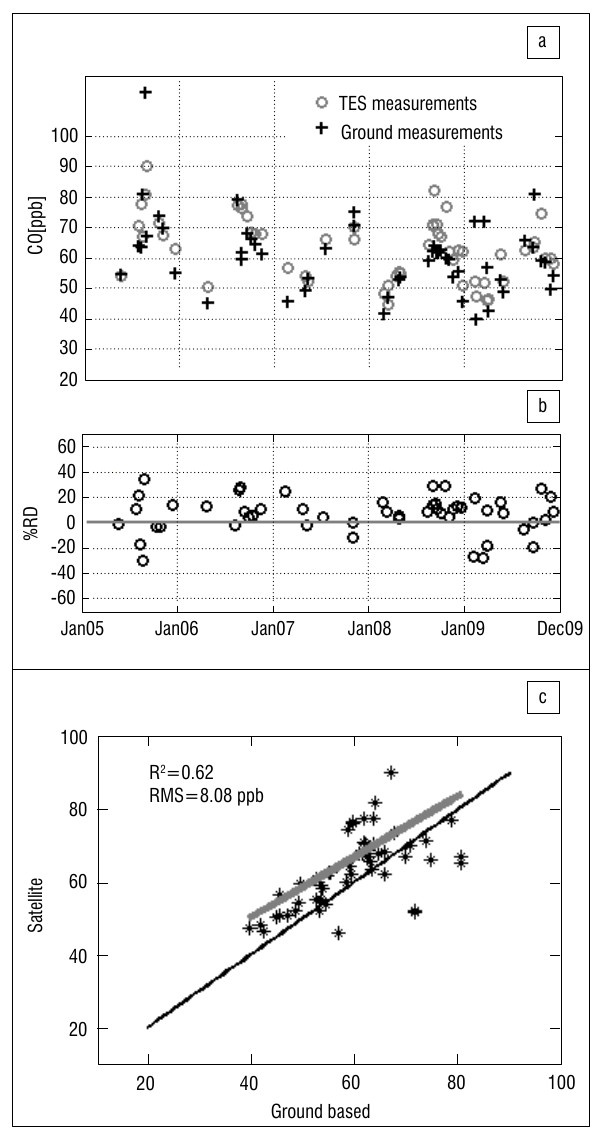
Figure 5: (a) Inter-annual variation of CO observed over Cape Point by the tropospheric emission spectrometer (TES) and from surface measurements at the Cape Point Global Atmosphere Watch station (ground) for the days on which there are both ground-based and TES observations under oceanic air mass conditions. (b) The relative difference (RD) observed between the two observations. (c) Scatter plot between TES satellite and ground-based observations over Cape Point; the black line represents the zero bias line while the bold grey line is the regression line between the two observations.